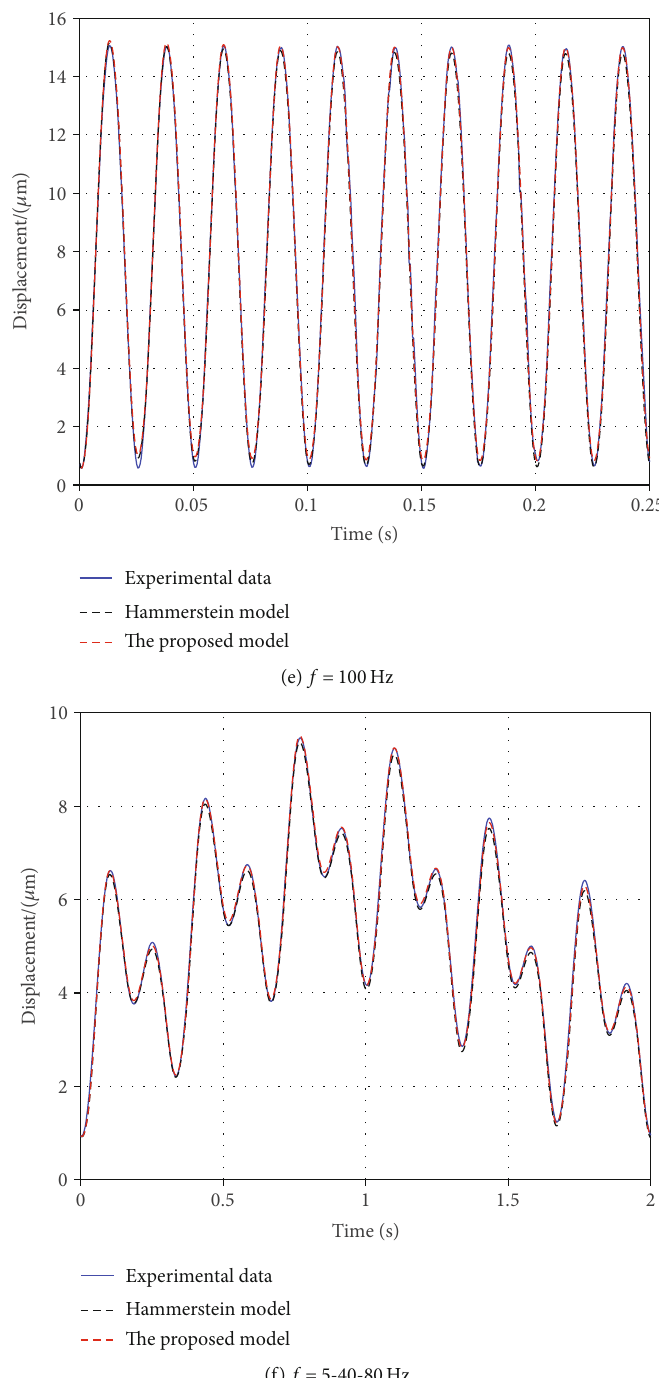
Figure 4: Displacement output comparison of Hammerstein model and the proposed